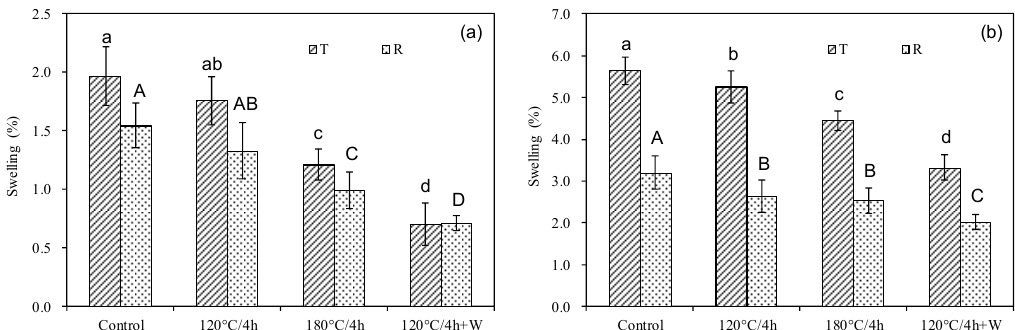
Figure 2. Tangential and radial swelling of the control and treated wood: ( a ) water vapor sorption and ( b ) water immersion. Bars with different letters indicate significant difference ( p < 0.05) in accordance with Duncan’s multiple range tests. Note: There are no significant differences between groups containing the same letters. The bar with ab means that there are no significant differences between this group and groups labeled with a or b, while the bar with AB means that there are no significant differences between this group and groups labeled with A or B.